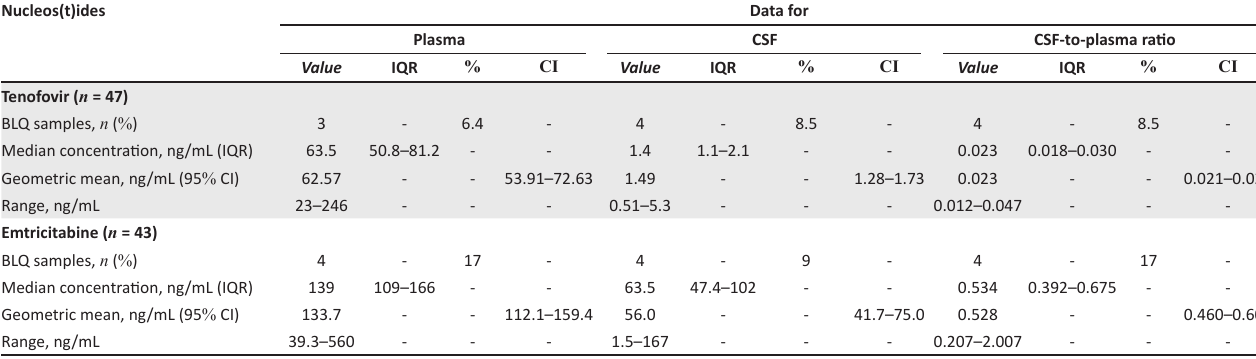
Table 1. TABLE 1: Concentrations of tenofovir and emtricitabine in plasma and cerebrospinal fluid. Nucleos(t)ides Data for